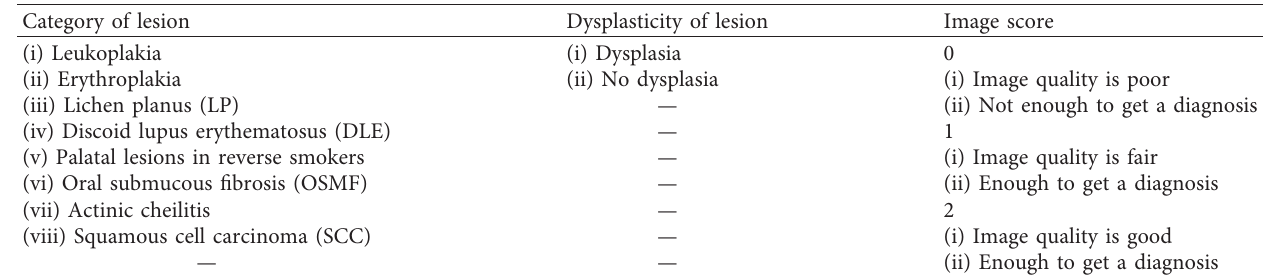
Figure 5: The study workflow. Table 1: Parameters of the